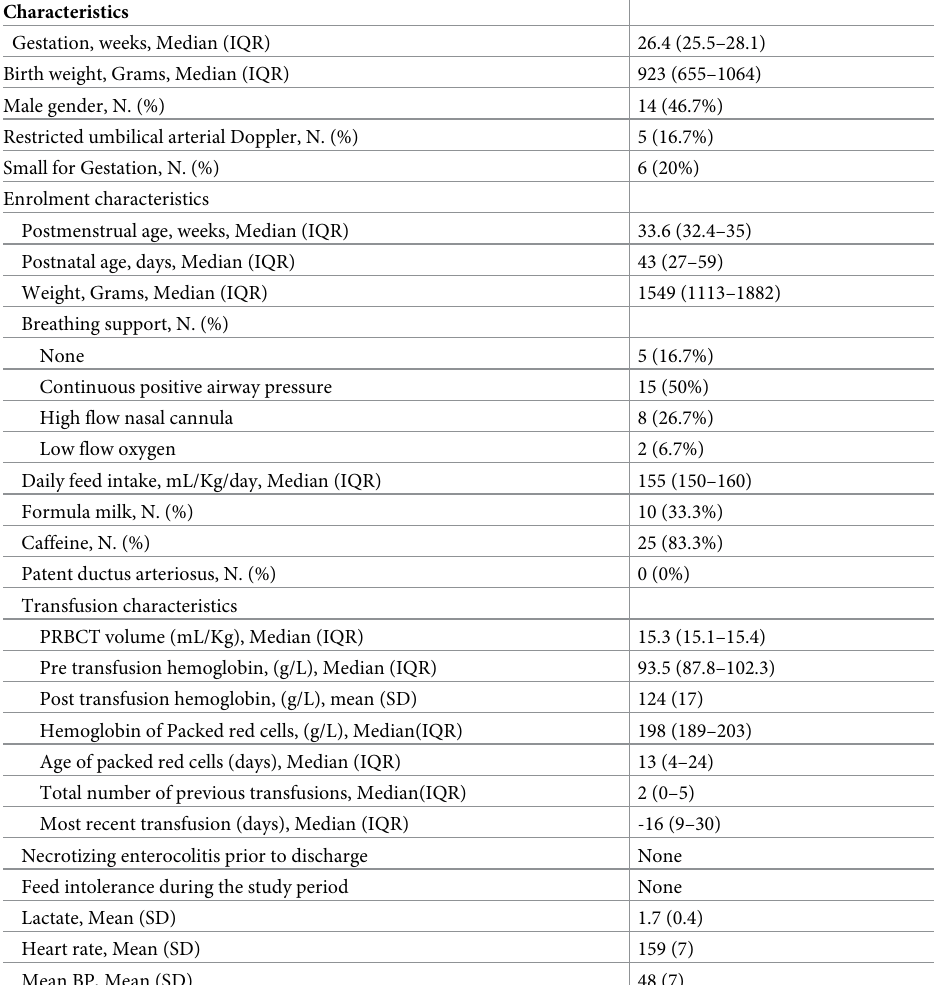
Table 1. Main clinical characteristics of patients (N =